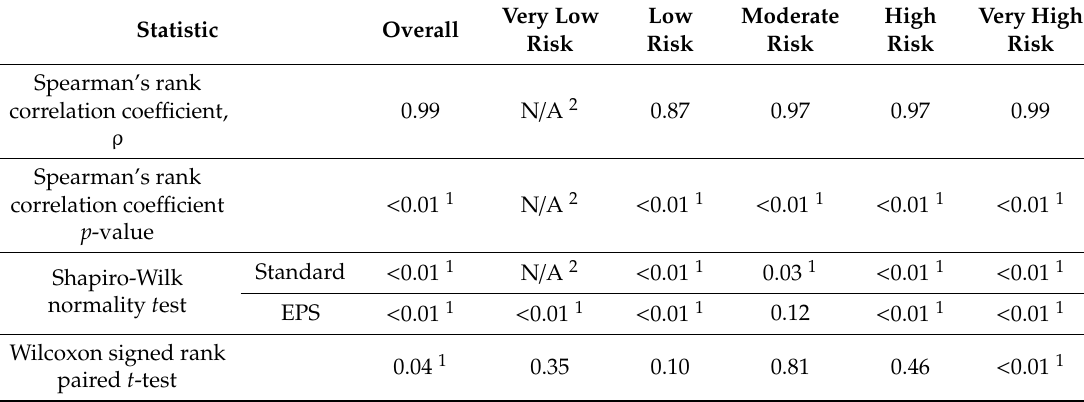
Table 2. P-values resulting from Spearman’s rank correlation coe ffi cients, Shapiro-Wilk normality tests and Wilcoxon signed rank sum tests on overall and categorical data.